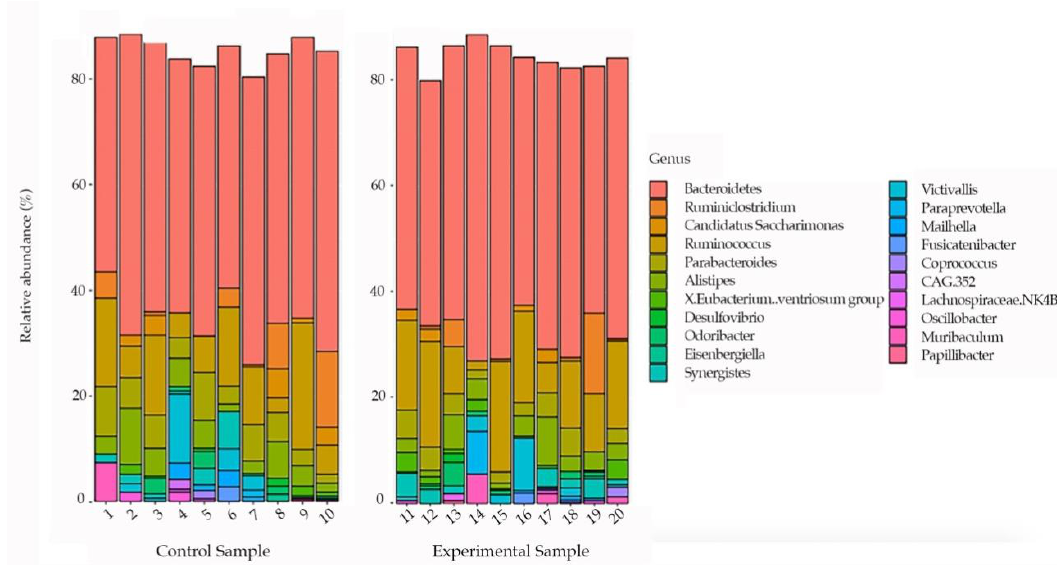
Figure 4. Bar plots showing the 10most abundant bacterial genera. We represented the ASVs > 1% among the 10most abundant bacterial genera. Each column represents a sample.